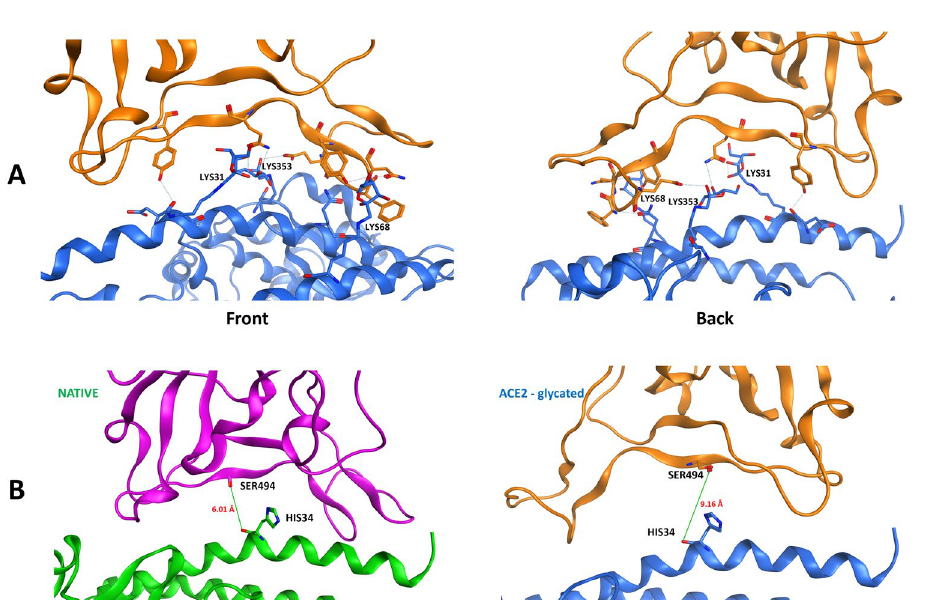
Figure 3. ( A ) Front and back highlight of the viral Spike protein (orange) binding to glycated ACE2 receptor (blue). The lysine amino acid residues subjected to glycation on ACE2 receptor are labelled in the image. ( B ) Difference in the distances between the first two cases considered. On the left: the classical interaction in PDB 6M0J, in which the distance between the carbonyl oxygen atoms of ACE2 receptor (green) HIS34 and Spike protein RBD (violet) SER494 is 6.01 Å. On the right: the interaction between glycated ACE2 receptor (blue) and native Spike protein RBD (orange). In this case, the distance between the carbonyl oxygen of ACE2 receptor (blue) HIS34 and Spike protein RBD (orange) SER494 is 9.16